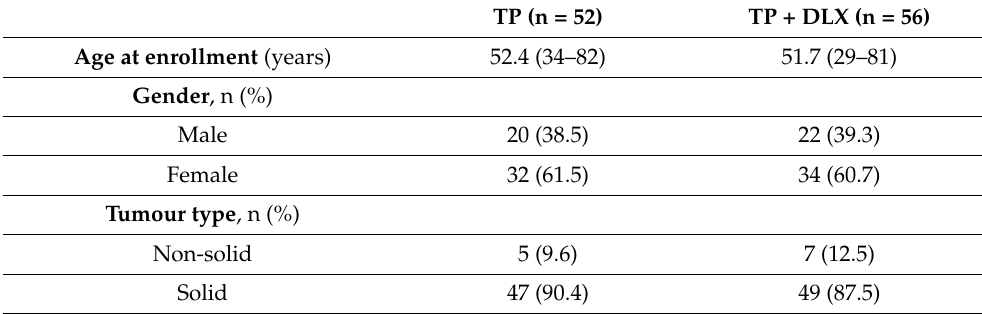
Table 1. Demographic and baseline characteristics of the 108 enrolled